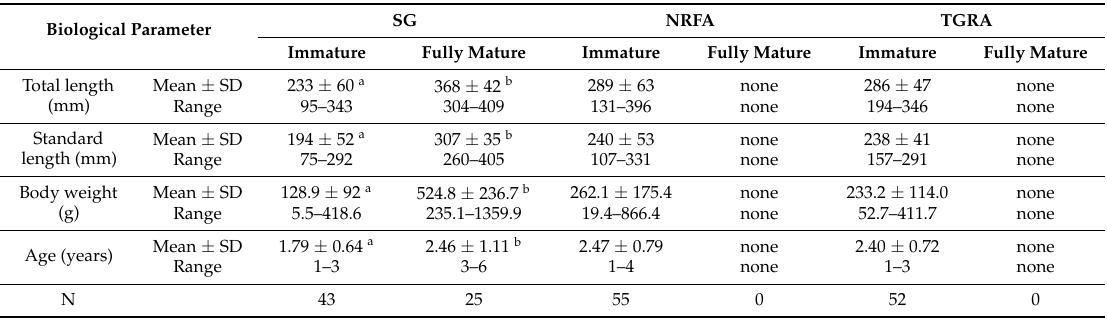
Table 1. Comparisons of the basic biological parameters among three habitat types in the upper Yangtze